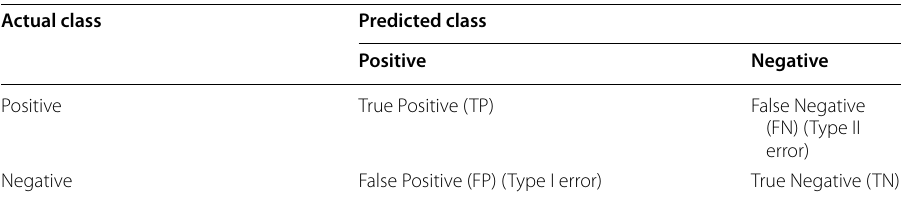
Table 18 Confusion